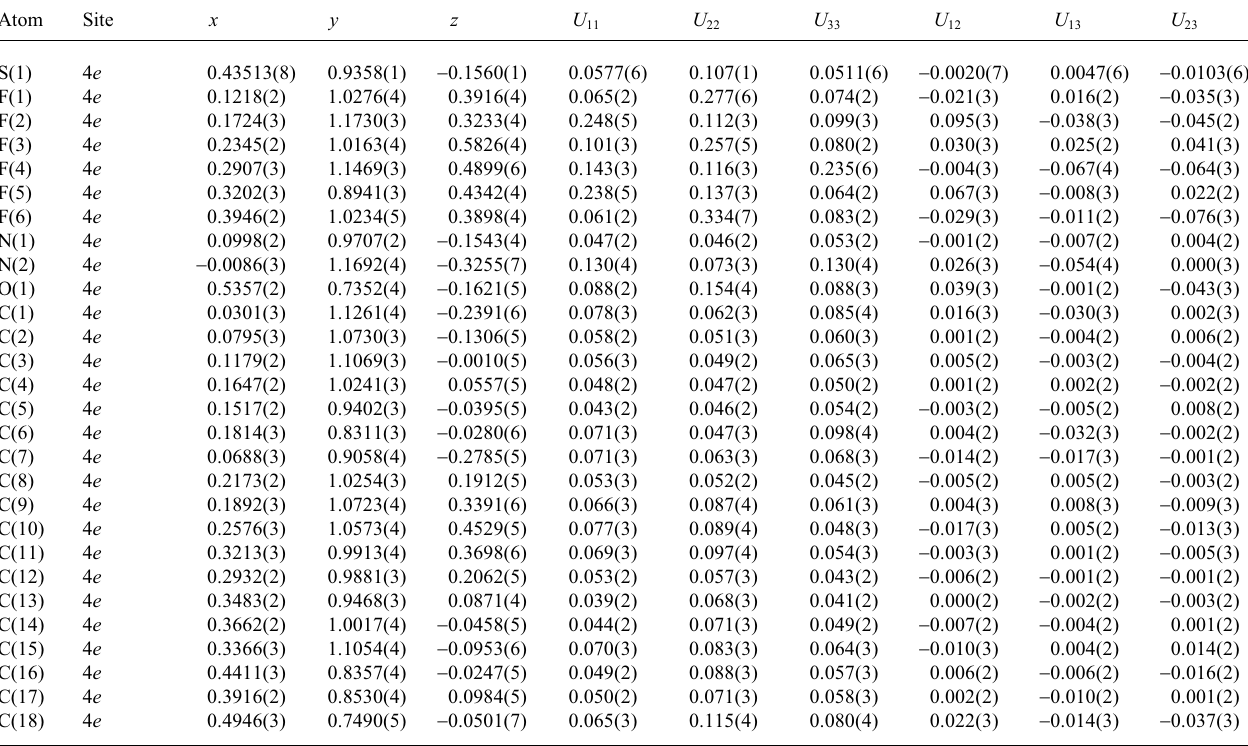
Table 3. Atomic coordinates and displacement parameters (in Å 2 )